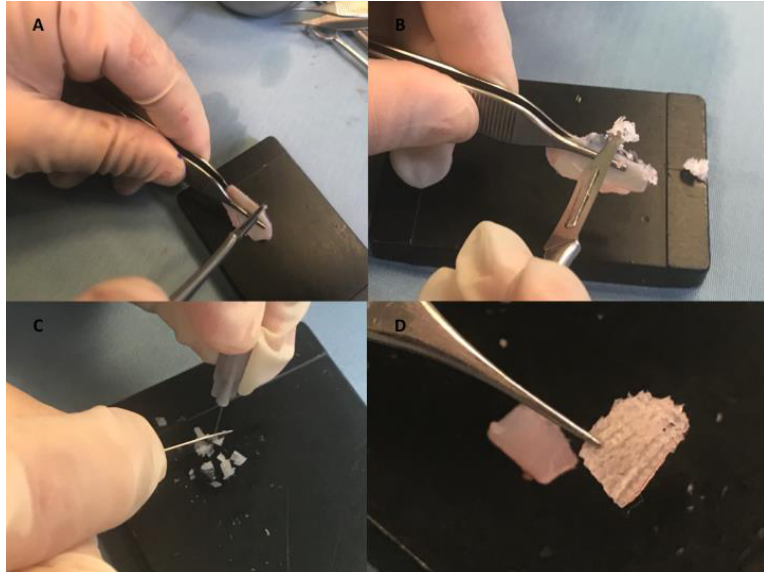
Figure 1. Autologous fluid shaving cartilage preparation compared with other products. ( A ) Cartilage preparation using as source nasal septum (with or without perichondrium). ( B ) Soft tissue attachments were debrided from the cartilage block using Adson Brown forceps in the non-dominant hand of the surgeon and surgical blade (number 15) in the perpendicular plane to scratch the edges of the cartilage block with very gentle pressure shaving very thin and small pieces. ( C ) Diced cartilage. ( D ) Crushing cartilage.